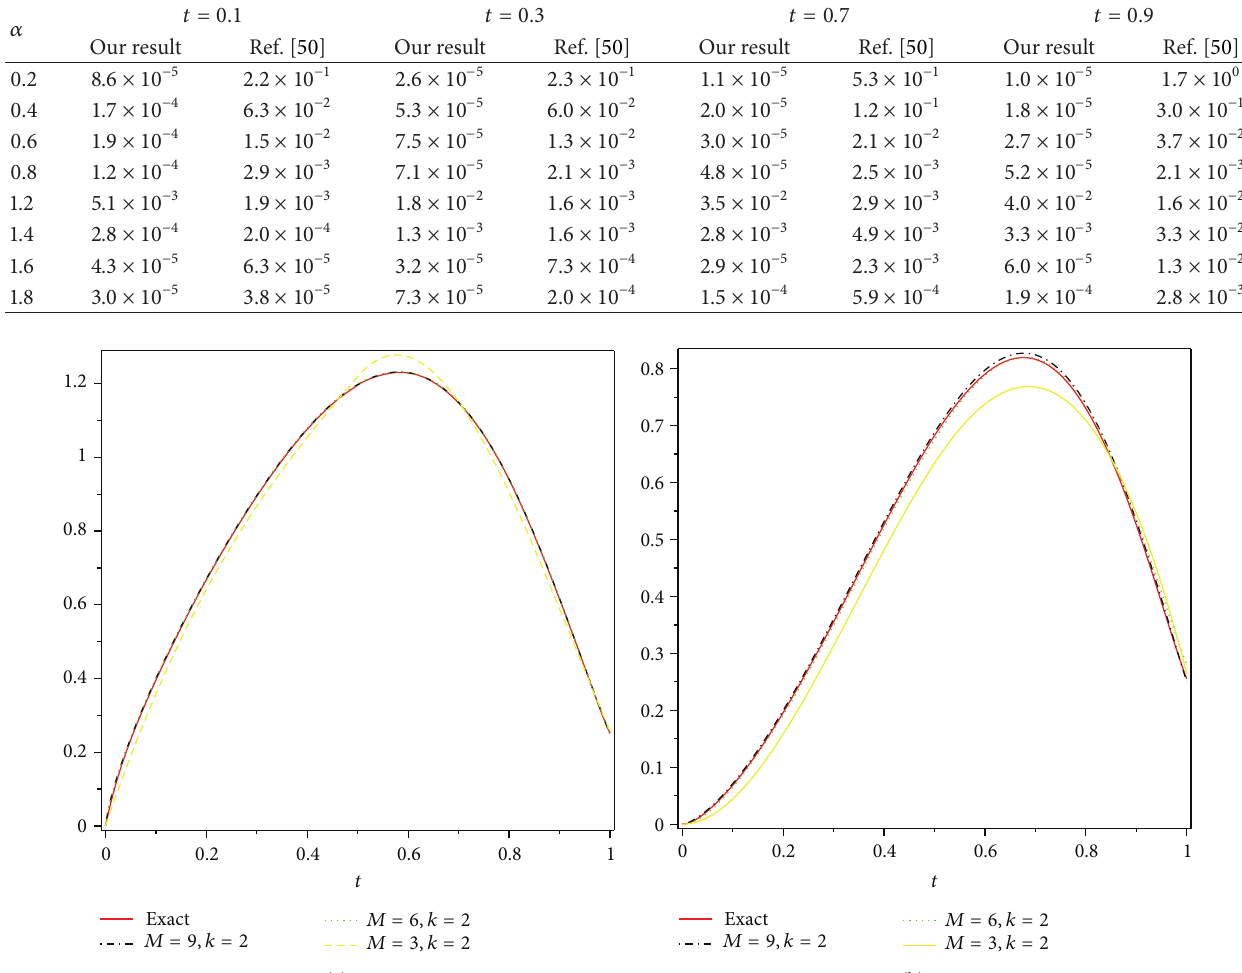
Figure 1: Comparison of 𝑦(𝑡) for 𝑀 = 9, 6, 3 and 𝑘 = 2 and (a) 𝛼 = 0.75 , (b) 𝛼 = 1.5 , with exact solution, for Example 1.